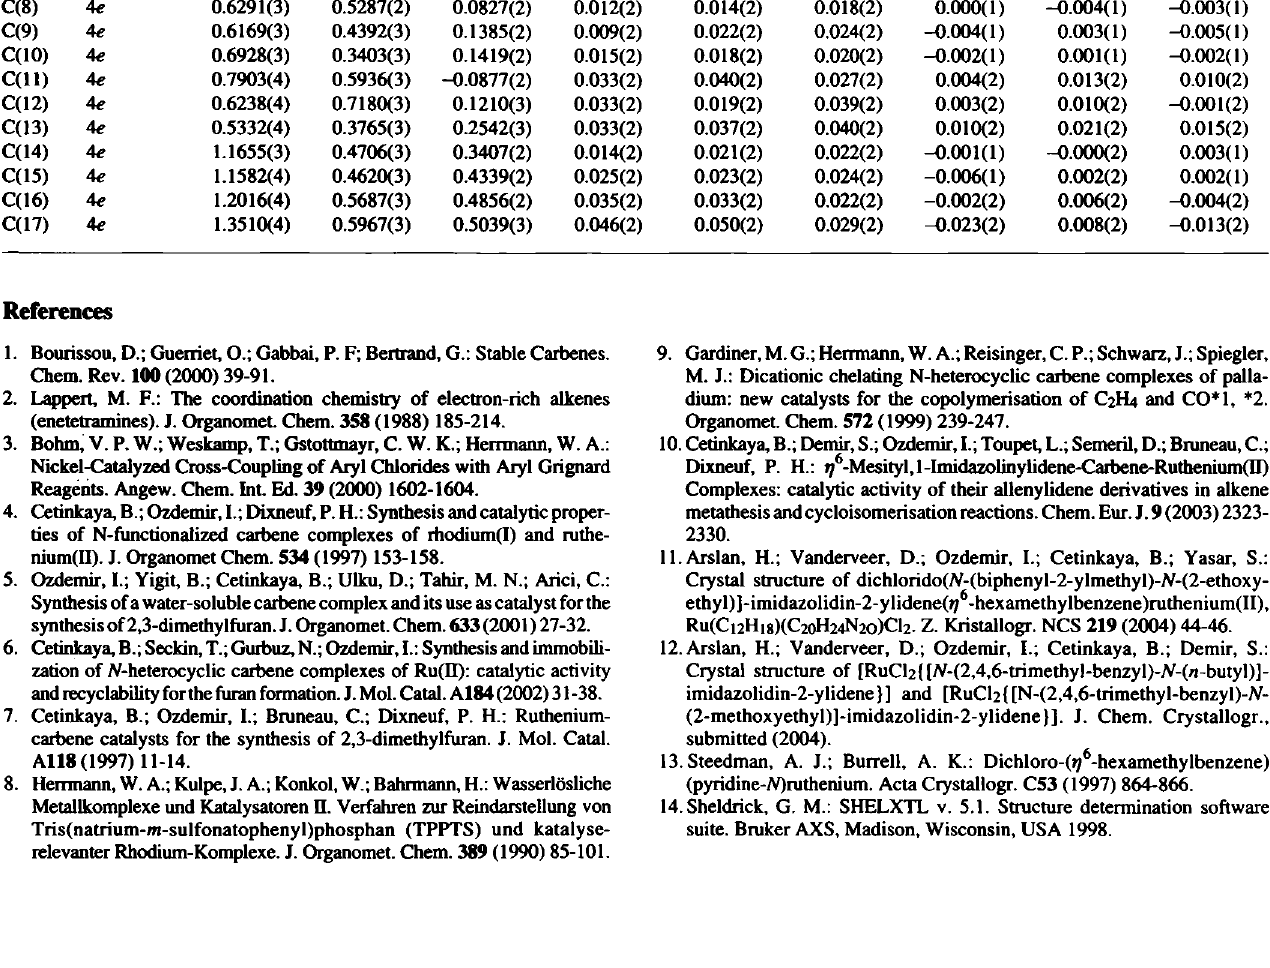
Table 3. Atomic coordinates and displacement parameters (in Â 2